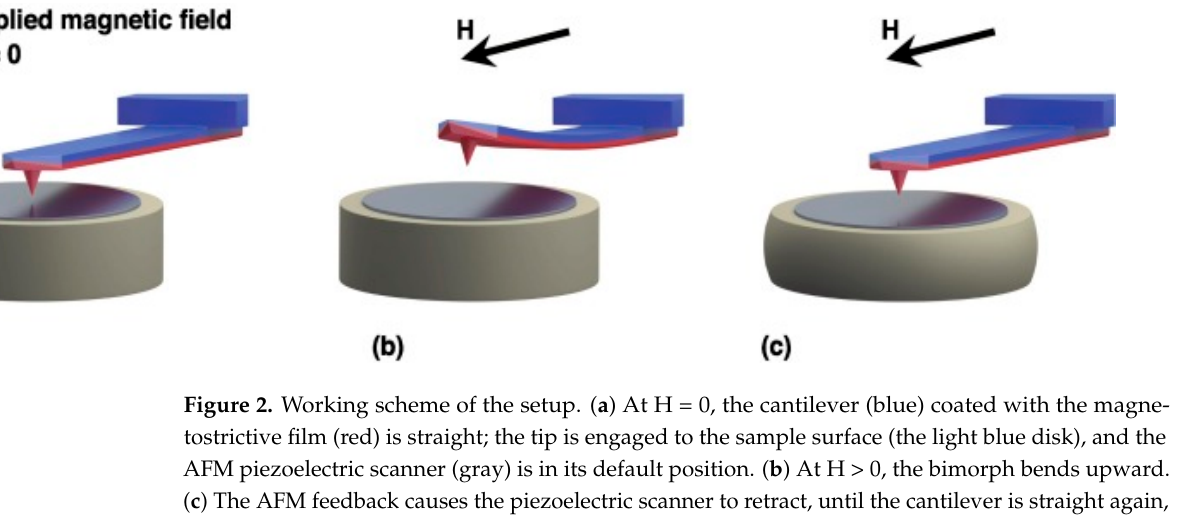
Figure 1. Schematics of the standard MFM microcantilever with tip and the Cartesian coordinate system.